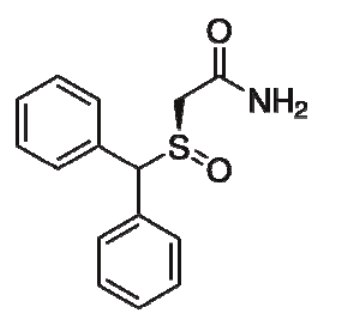
Figure 1. Chemical structure of